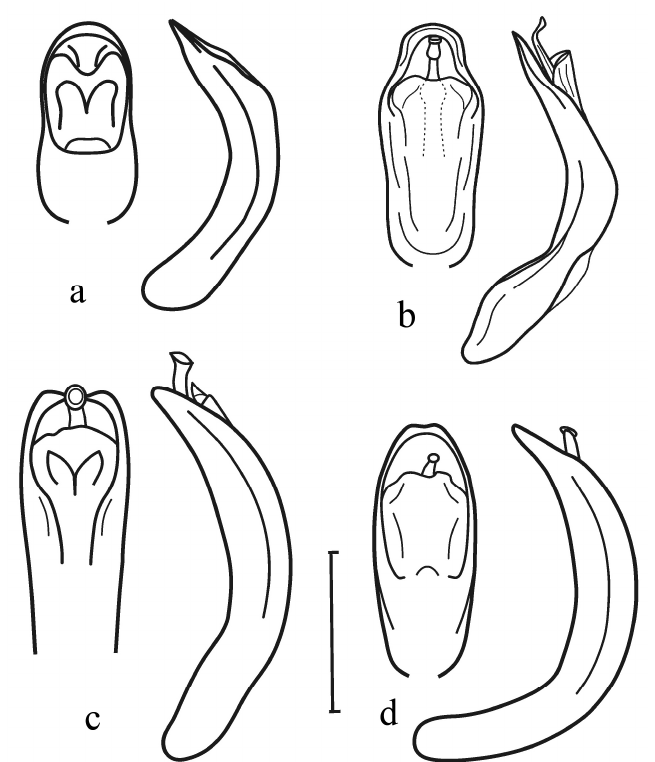
Figure 7. Aedeagus in dorsal and lateral view: ( a )— Sternoplatys clementzi Jacobson, 1901 (Russia, Tyva Republic, Mongun-Taiga Massif); ( b )— Apterocuris sibirica Jacobson, 1901 (Russia, Kemerovo Region, Kuznetsky Alatau Mts.); ( c )— Sclerophaedon carniolicus Germar, 1824 (Austria, Bubenberg, Spielfeld); ( d )— Sclerophaedon carpathicus (Ukraine, Transcarpathia, Marmarosh Massif). Scale bar—0.5 mm.